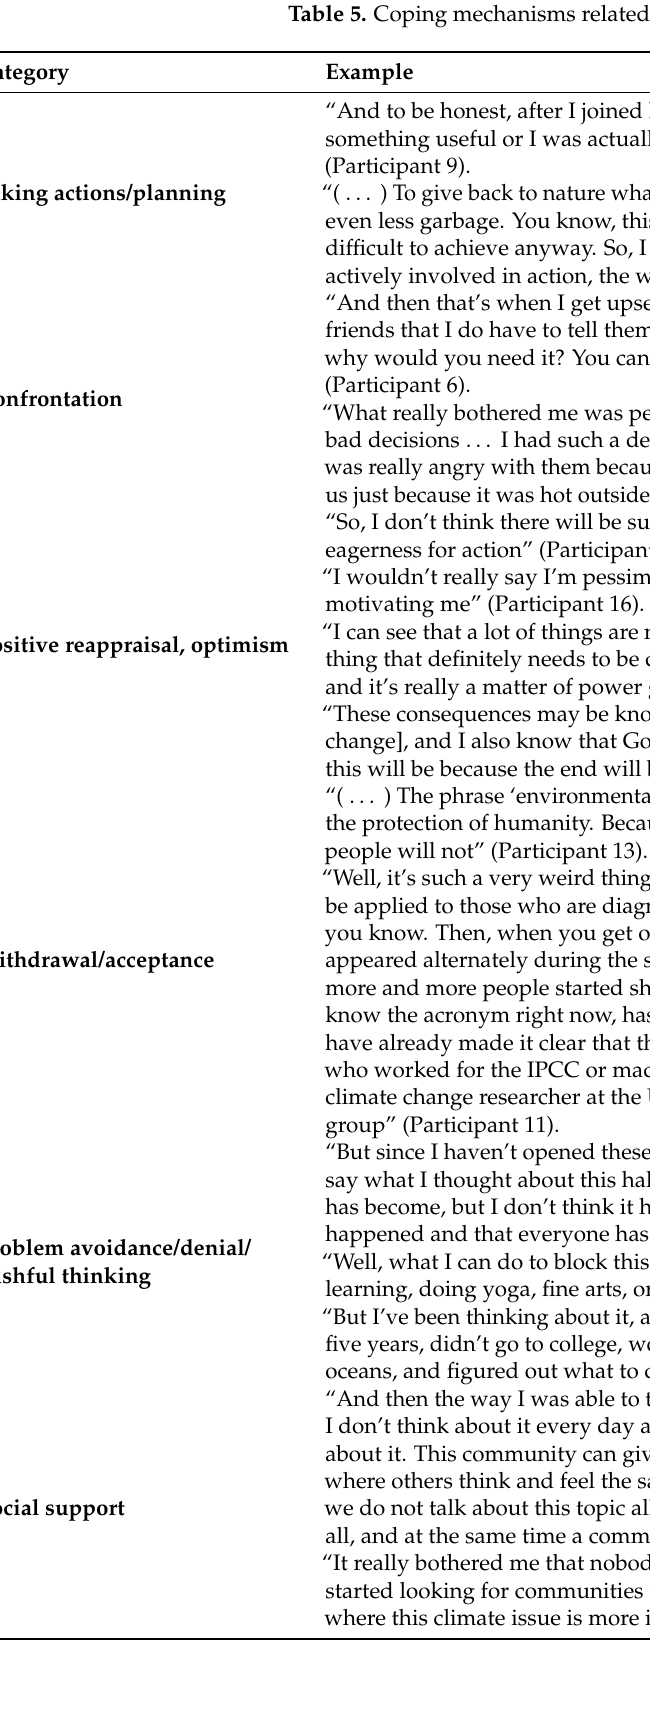
Table 5. Coping mechanisms related to eco-anxiety, eco-guilt, and